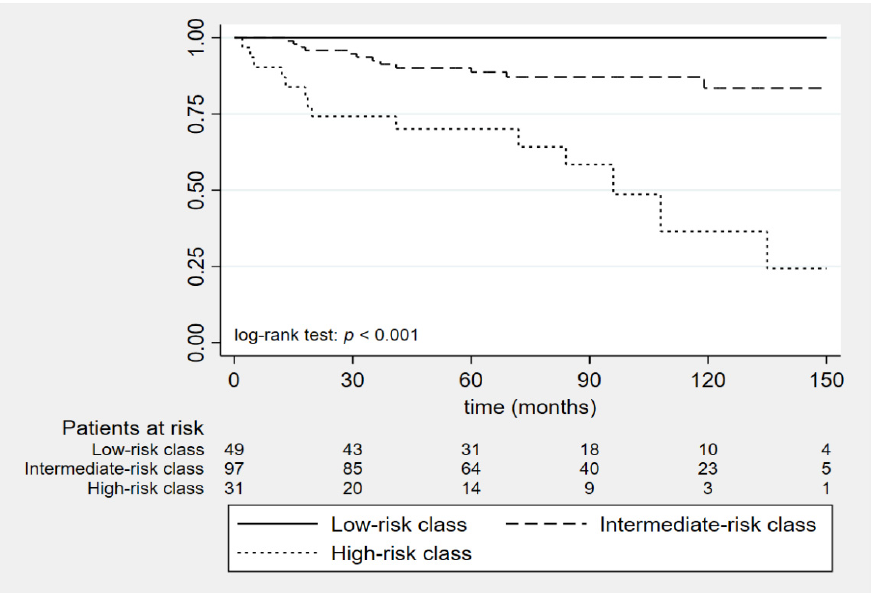
Figure 2. Kaplan–Meier curves for recurrence-free survival according to SGAP-score risk classes. Abbreviations: SGAP, Size–Genetic–Age–PASS. Abbreviations: SGAP,